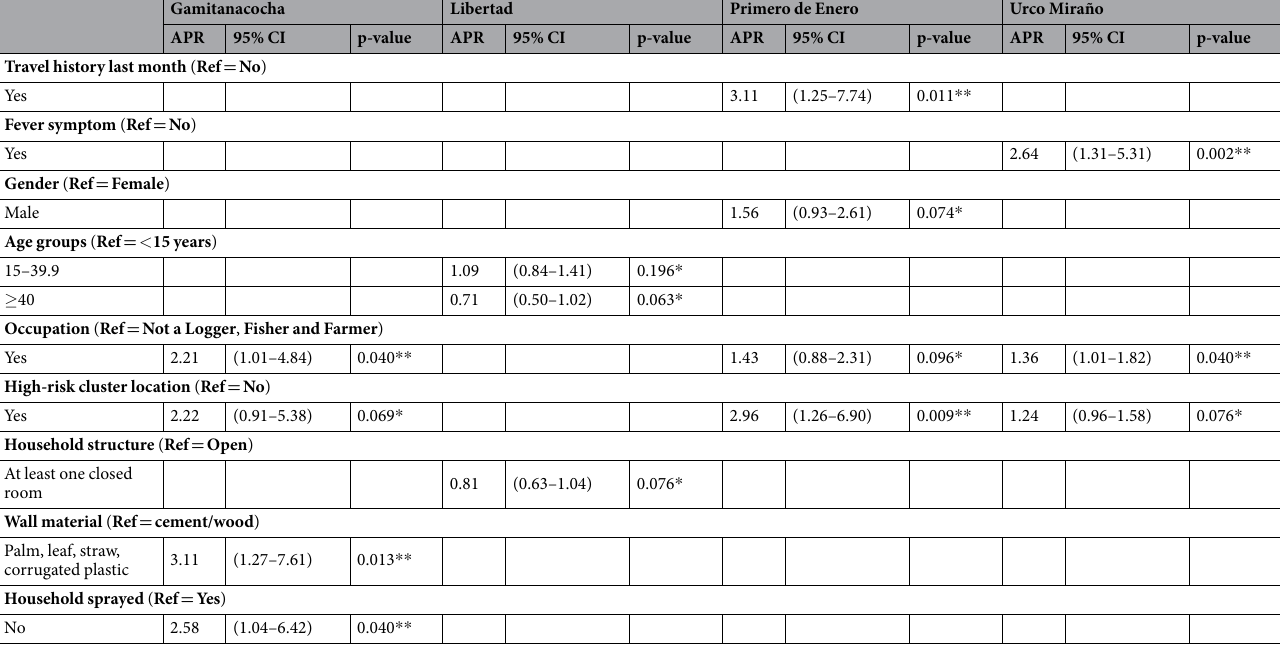
Table 5. Fixed effects of community-specific multivariate models for P . vivax parasitaemia. Mixed-effect Poisson Models; APR = Adjusted Prevalence Ratio; p-values and 95% CI adjusted by Adaptive False